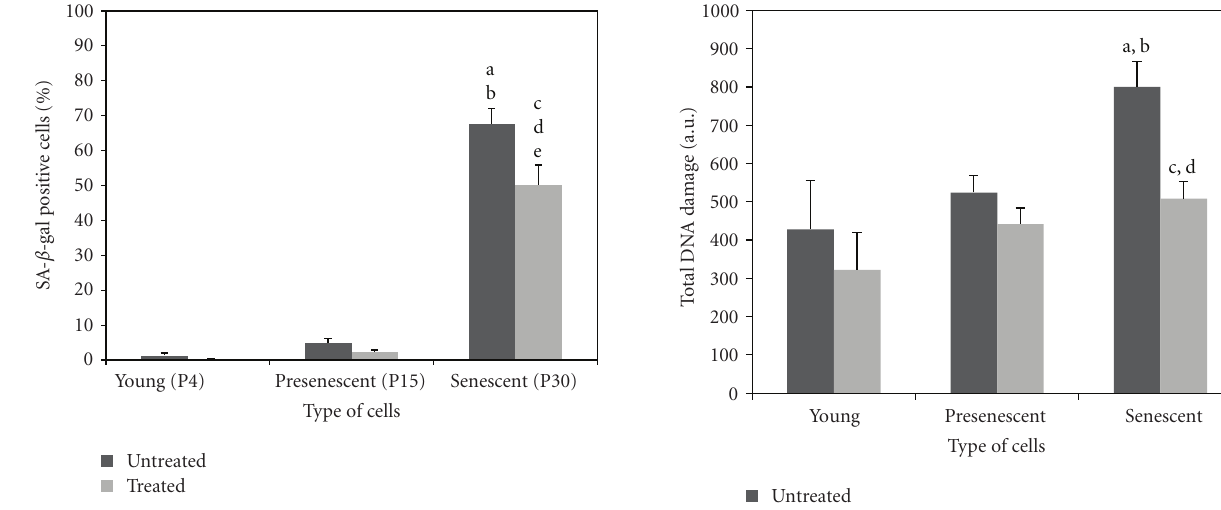
Figure 4: Quantitative analysis of positive β -galactosidase stained cells in HDFs during cellular ageing. The percentage of cells positive for SA- β -gal staining was significantly increased in senescent cells. Incubation of senescent cells with TRF significantly decreased the percentage of cells positive for SA- β -gal staining. a Denotes P < . 05 compared to untreated young HDFs, and b P < . 05 compared to untreated presenescent HDFs, c P < . 05 compared to untreated senescent HDFs, d P < . 05 compared to treated young HDFs, e P < . 05 compared to treated presenescent HDFs. Data are presented as mean ± SEM, n = 6.